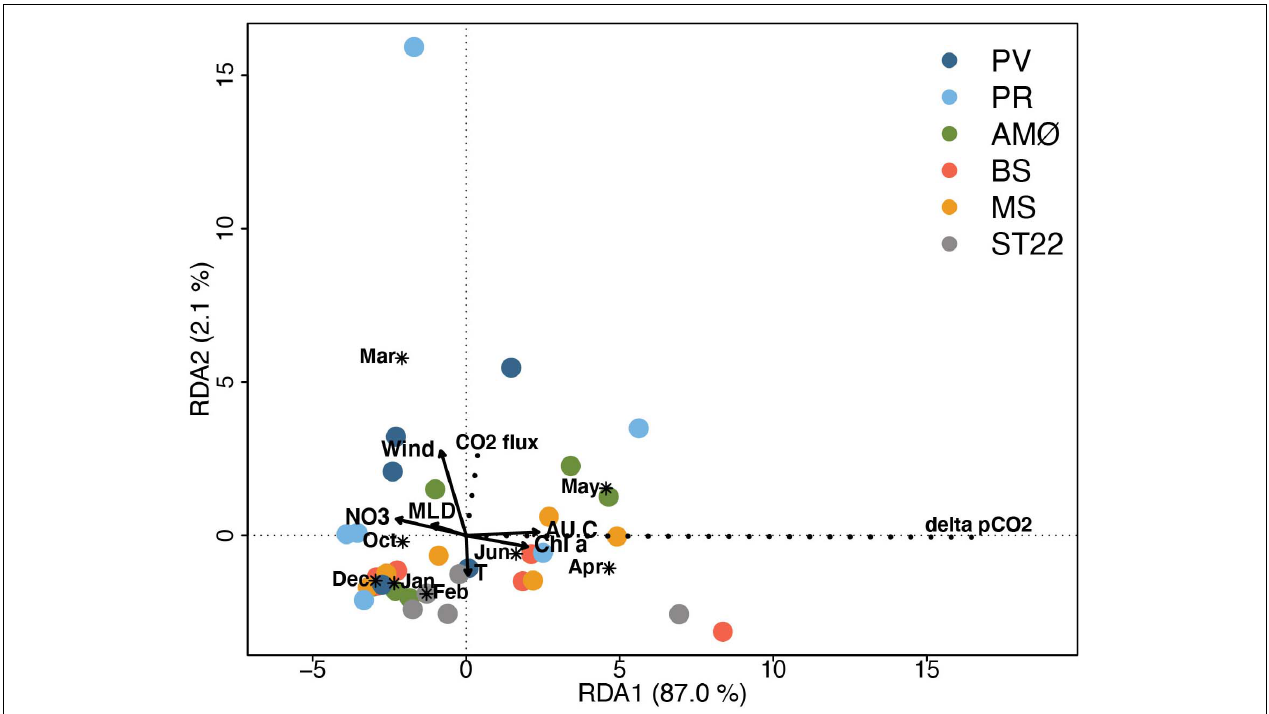
FIGURE 6 | Triplot showing RDA ordination analysis. The eigenvalue of axis 1 (RDA1) and axis 2 (RDA2) are 0.870 and 0.021, respectively, accounting for 89.1% of the total variance. CO 2 flux and (cid:49) pCO 2 represent species (scaled by eigenvalues) and are indicated with dashed lines. Site scores (sampling events) are weighted average of species scores (wa scores) and marked with shapes per station. Quantitative environmental factors are indicated by arrows and qualitative environmental factor (month) by asterix (*) as centroid (weighted average) of site points belonging to the month. The scale marks along the axes apply to qualitative environmental variables and species; quantitative environmental scores were multiplied by 3 to fit in the coordinate system. Stations are marked with different